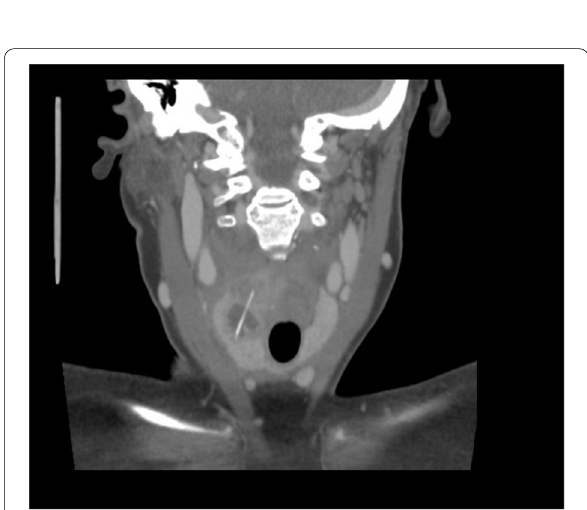
Fig. 2 CT scan neck: liner foreign body resembling fish bone